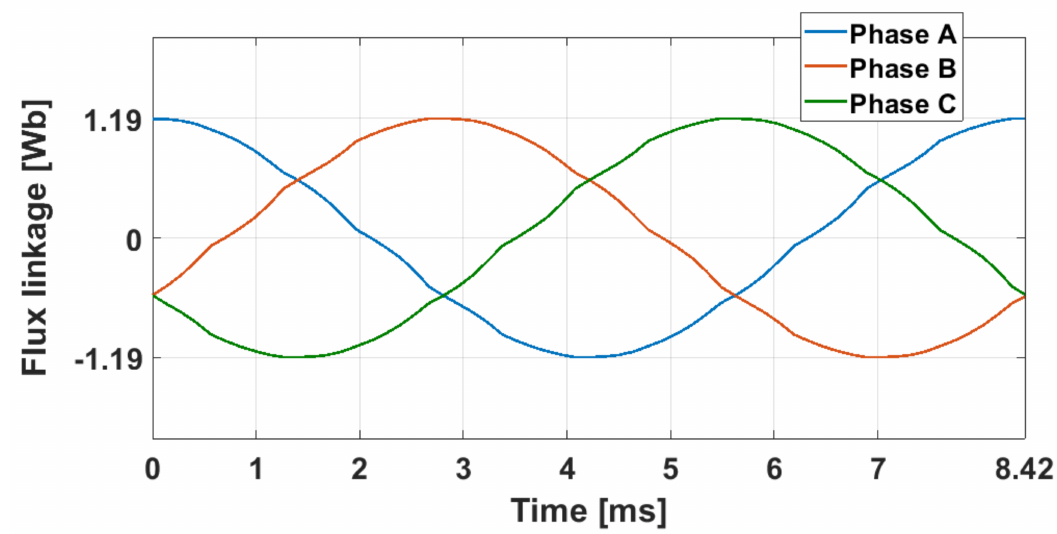
Figure 12. Stator winding flux linkage for the optimized